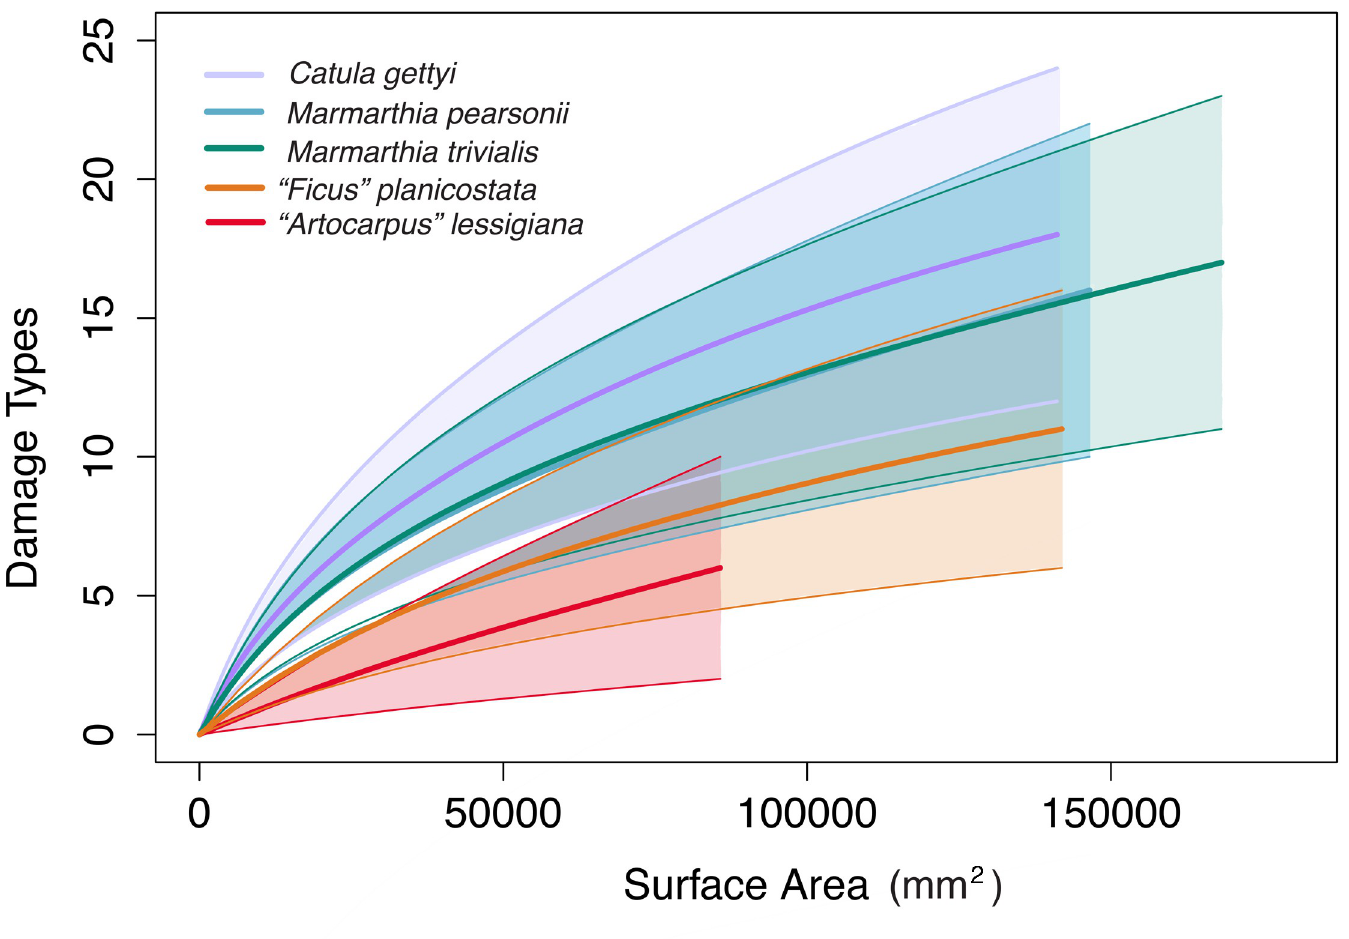
Fig 16. Rarefaction of damage types and total sampled surface area for Catula gettyi and the four Hell Creek taxa. The Hell Creek taxa are: Marmarthia pearsonii , M . trivialis , “ Artocarpus ” lessigiana , and “ Ficus ” planicostata .